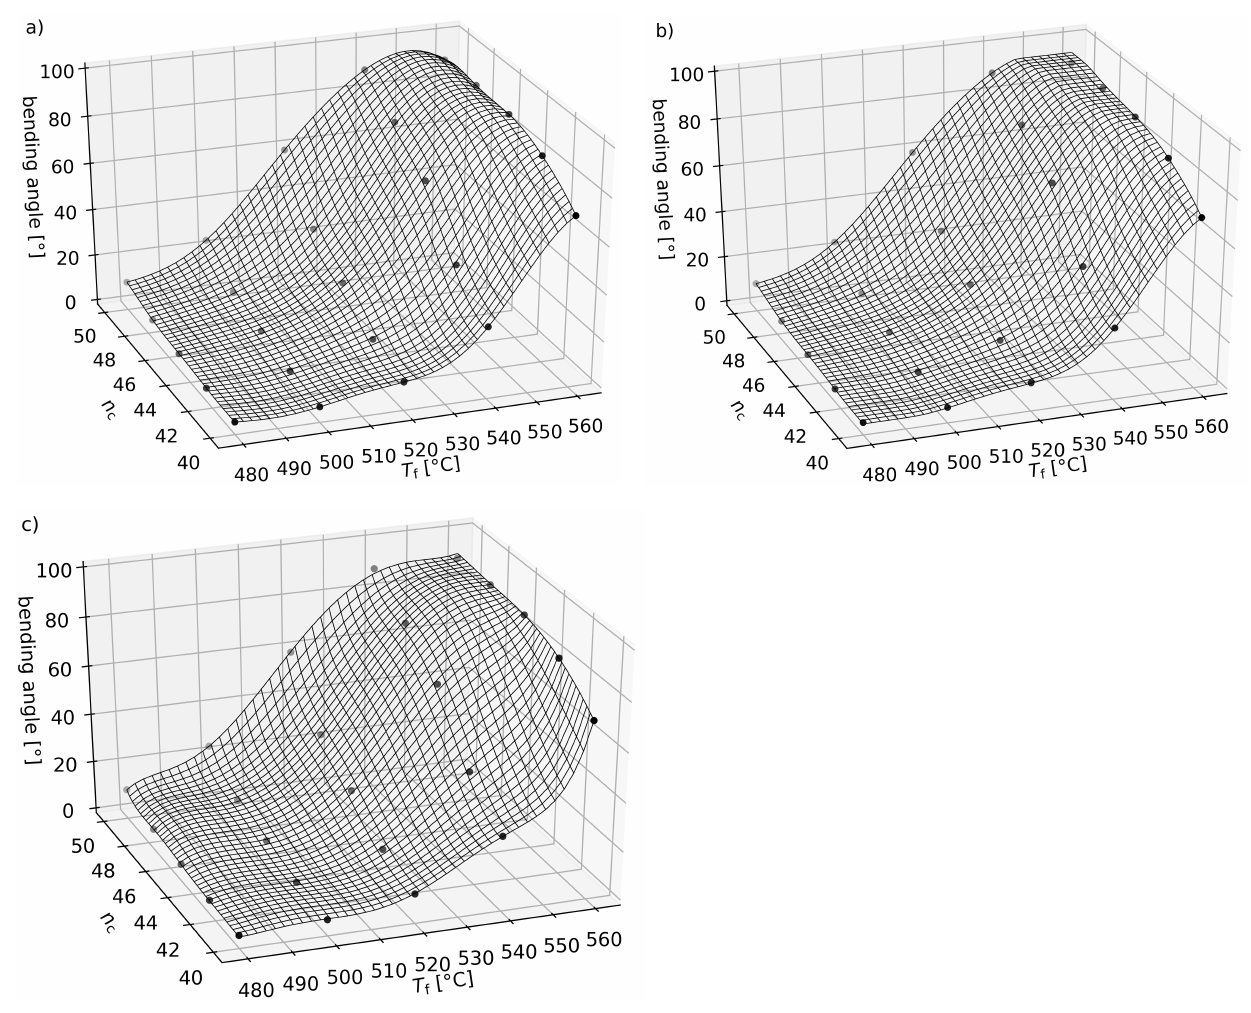
Figure 4. 2D regression for laser glass bending, where the markers represent the employed training data. ( a ) Gaussian process regression (non-monotonic) with a multi-length-scale RBF kernel (noise level 10 − 5 ); ( b ) projection [24] of GPR; ( c ) monotonic regression of a polynomial model ( m = 7) using the SIAMOR method (see Sections